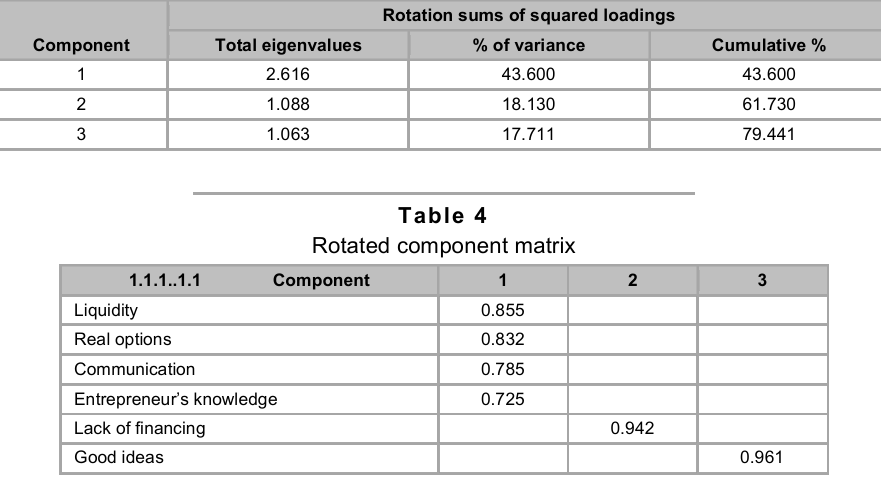
Total variance explained: venture capital funding market